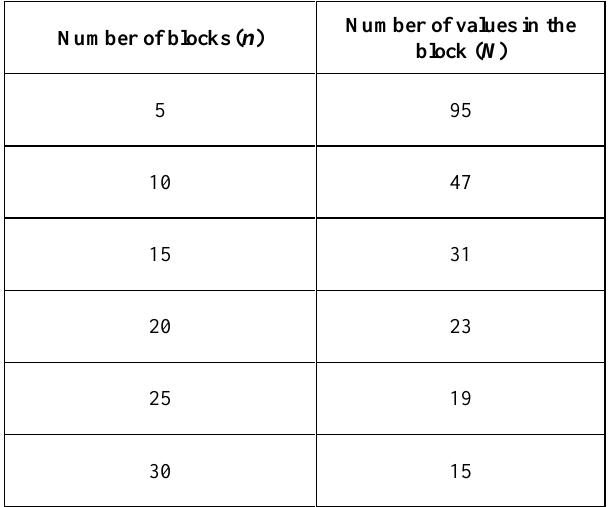
Table 3. Number of blocks and values in the blocks.